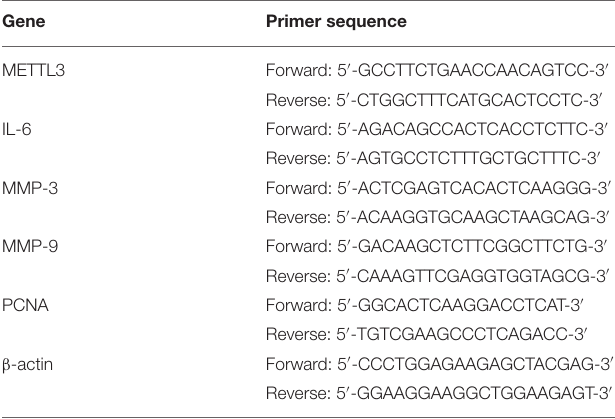
TABLE 2 | Primer sequences used in real-time quantitative PCR for human